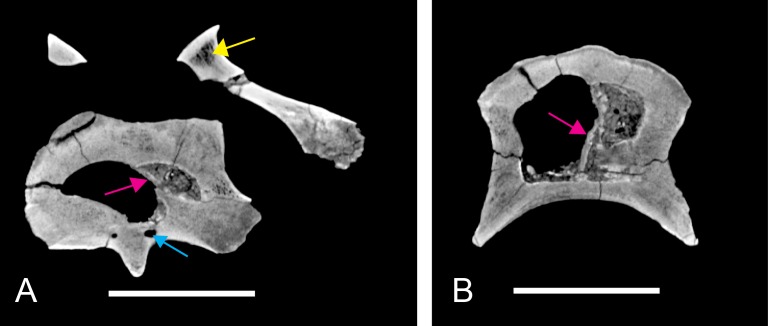
CT images of BSPG 2006 I 54.(A) slice through anterior part of the vertebra in popsterior view. (B) slice through centrum in dorsal view. Pink arrows indicate course of bony septum separating two large camerate chambers. The yellow arrow indicates hollow structure in prezygapophysis. The blue arrow indicates accessory foramen underneath transverse ridge. Scale bars equal 10 cm.